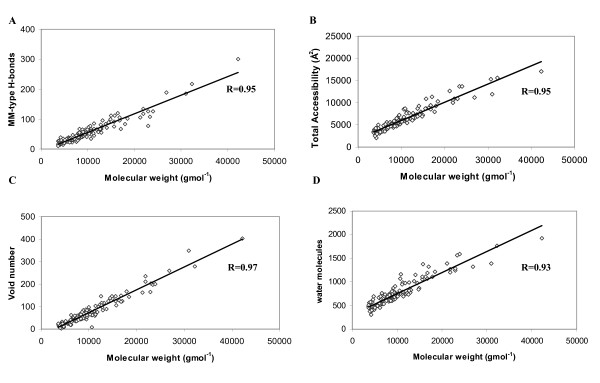
Parameters plotted against values of molecular weights obtained for each protein belonging to "mainly-alpha" class. (A) MM-type H-bonds (B) total accessibility (C) void number (D) water molecules. The data were fit by linear least squares (the equations obtained are in Additional file 4). The related correlation coefficients (R) are also reported.